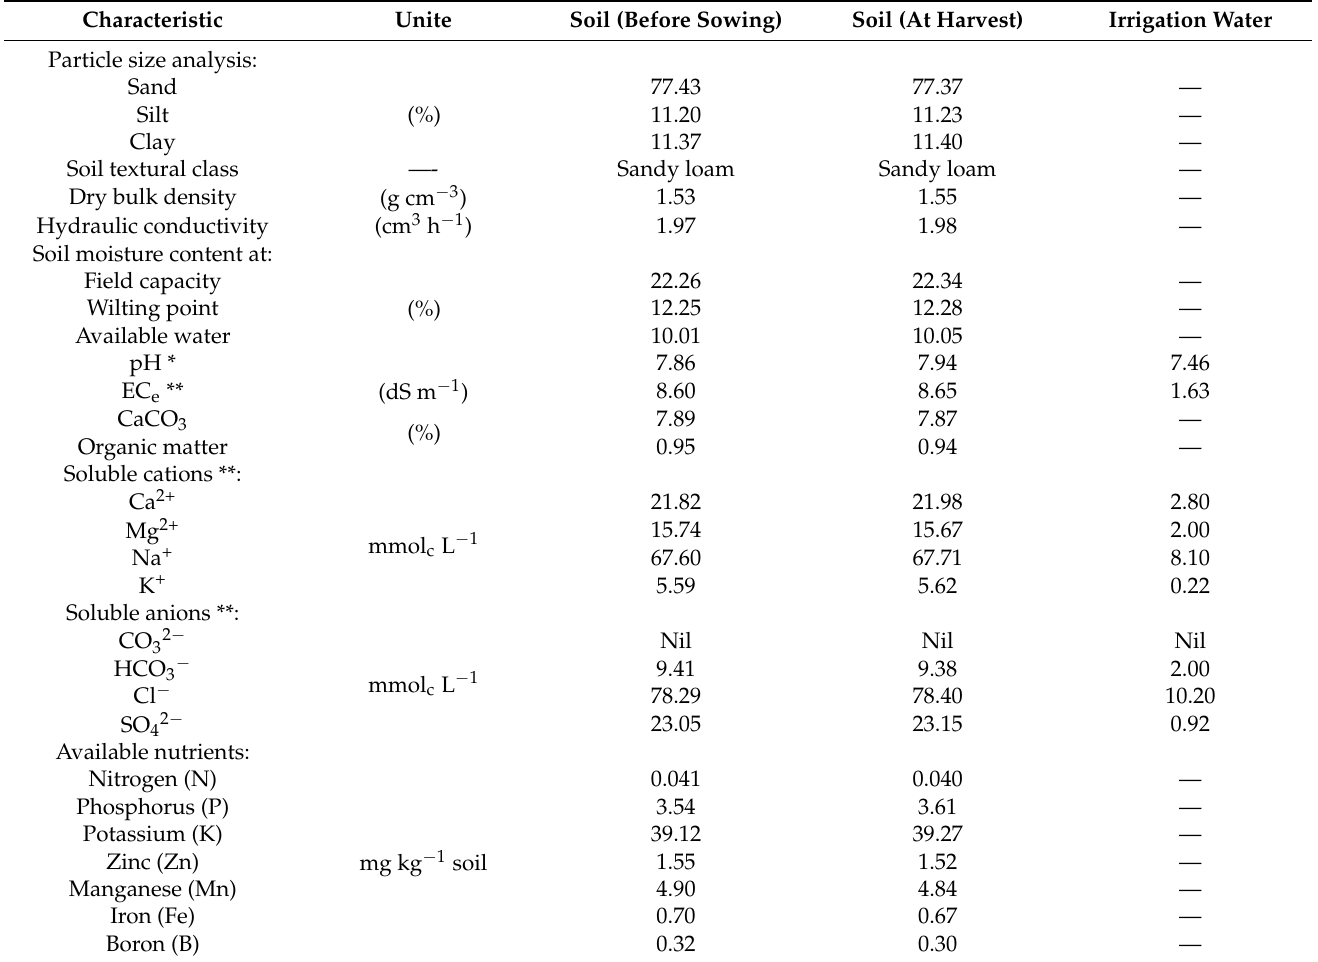
Table 2. Some properties of irrigation water and tested soil (0.0–60 cm depth) before planting and at harvest (data pooled over both growing seasons). Unite Soil (Before Sowing) Soil (At Harvest) Irrigation